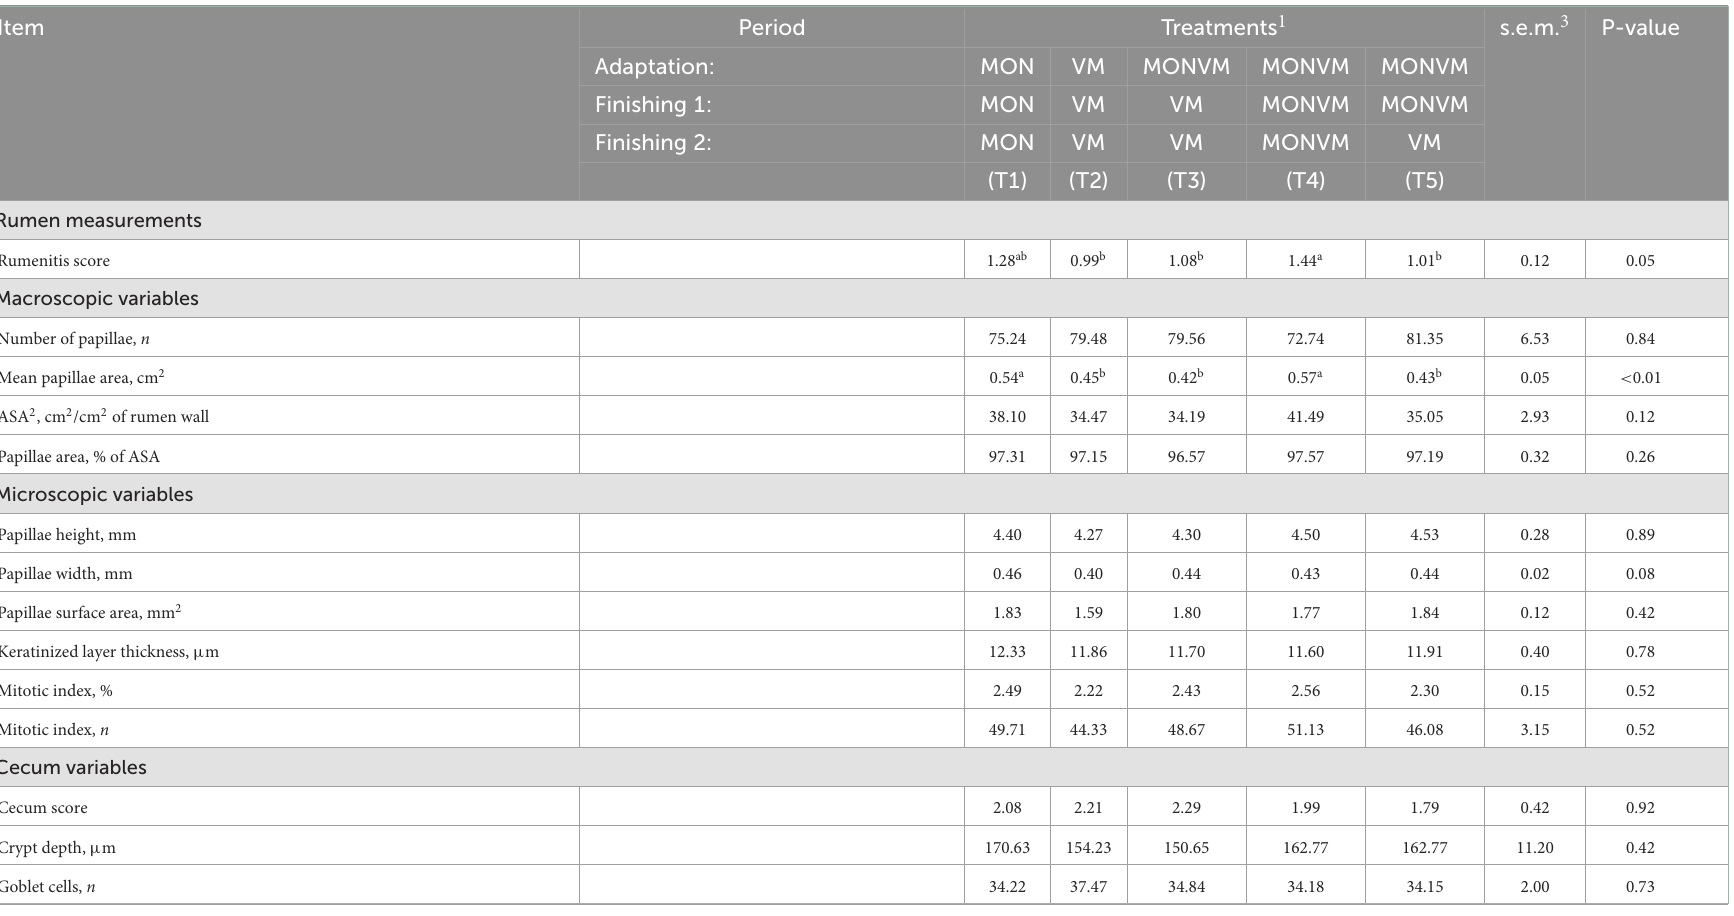
TABLE 6 Withdrawal of sodium monensin when associated with virginiamycin during adaptation and finishing periods on rumen and cecum morphometrics of Nellore yearling bulls ( n = 30) consuming high-concentrate diets. Item Period Treatments 1 s.e.m. 3 P-value Adaptation: